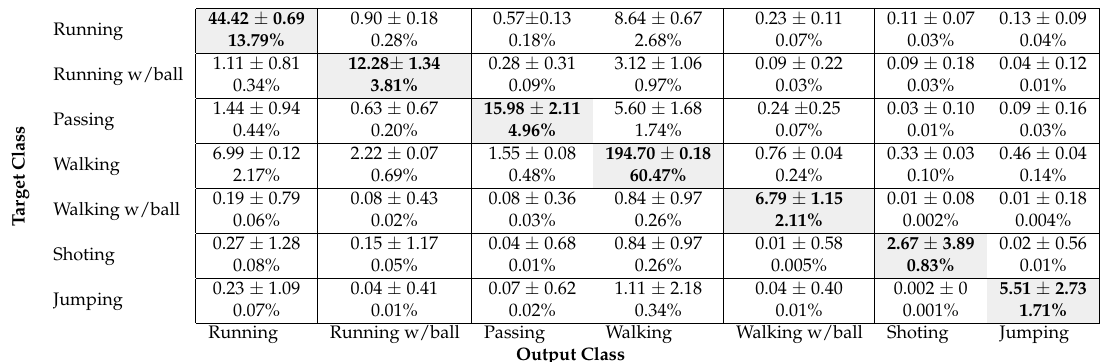
Table 9. DBMM Confusion Matrix.